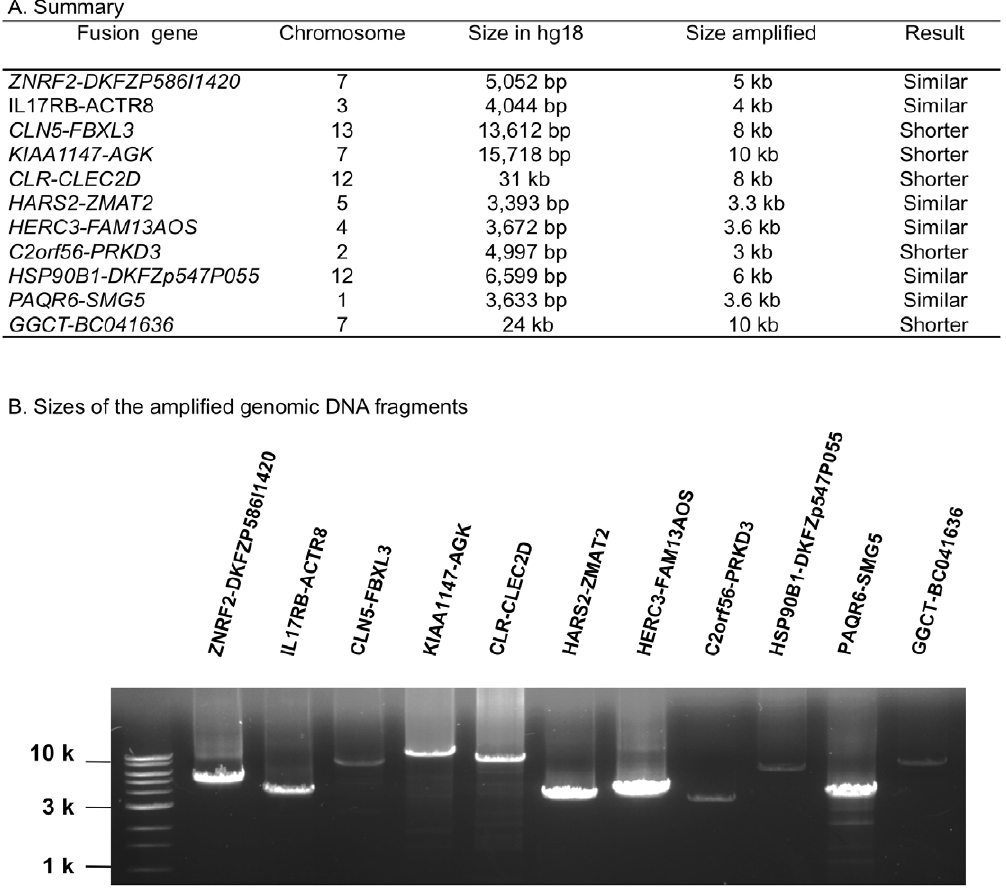
Figure 5. Long-range PCR results. A. Summary of the results from 11 fusion candidates. B. Size distribution of the amplified genomic DNA